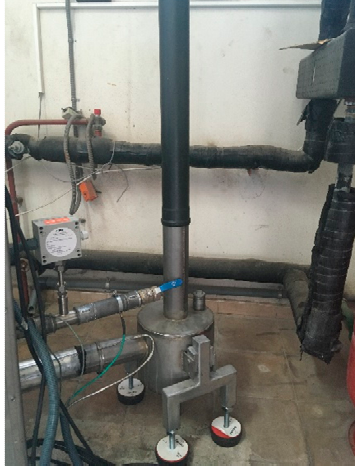
Figure 7. Gas treatment section.